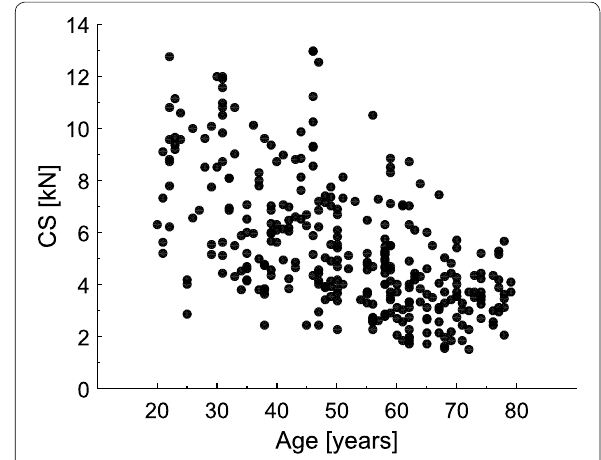
Fig. 2 Compressive strength (CS) of lumbar spine versus age. Data were taken from the works of Eie [30], Hansson et al. [25], Hansson and Roos [27], Hutton and Adams [26], Adams and Hutton [28], Brinckmann et al. [24, 31] and Ebbesen et al. [29]. Data obtained from Ebbesen et al. were read from the scatter plots. The age range was restricted to 20–79, considering the amount of data and the number of references. (N =